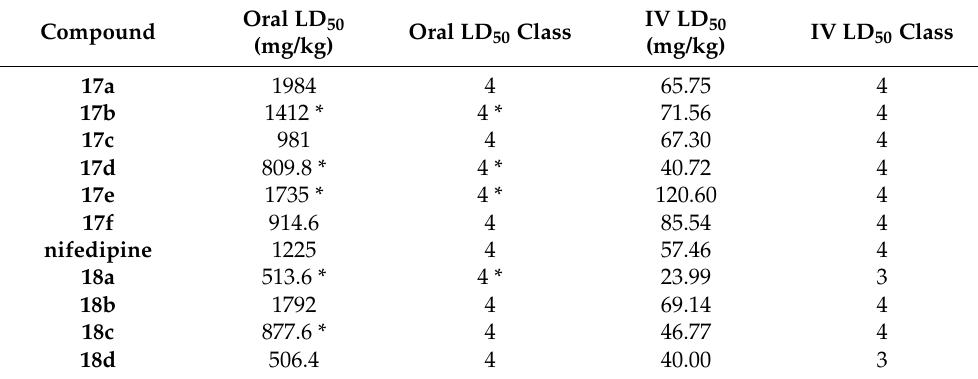
Table 5. The predicted toxicity of compounds 17a – f , nifedipine, and the modified structures 18a – d expressed as median lethal doses (LD 50 ) on rats using the GUSAR